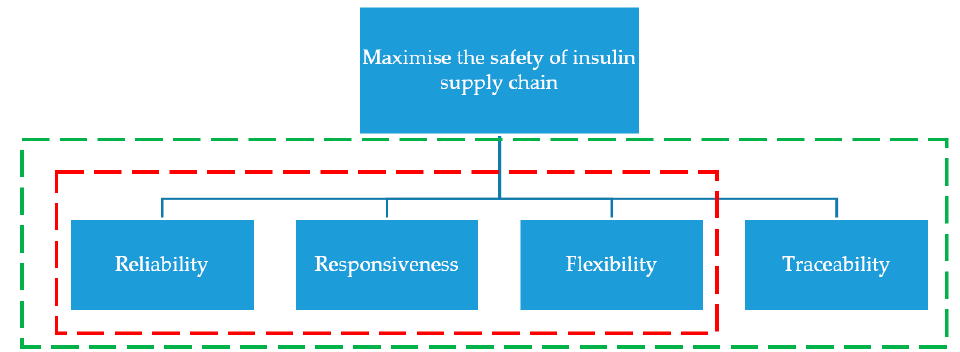
Figure 4. Selected SCOR performance attributes.